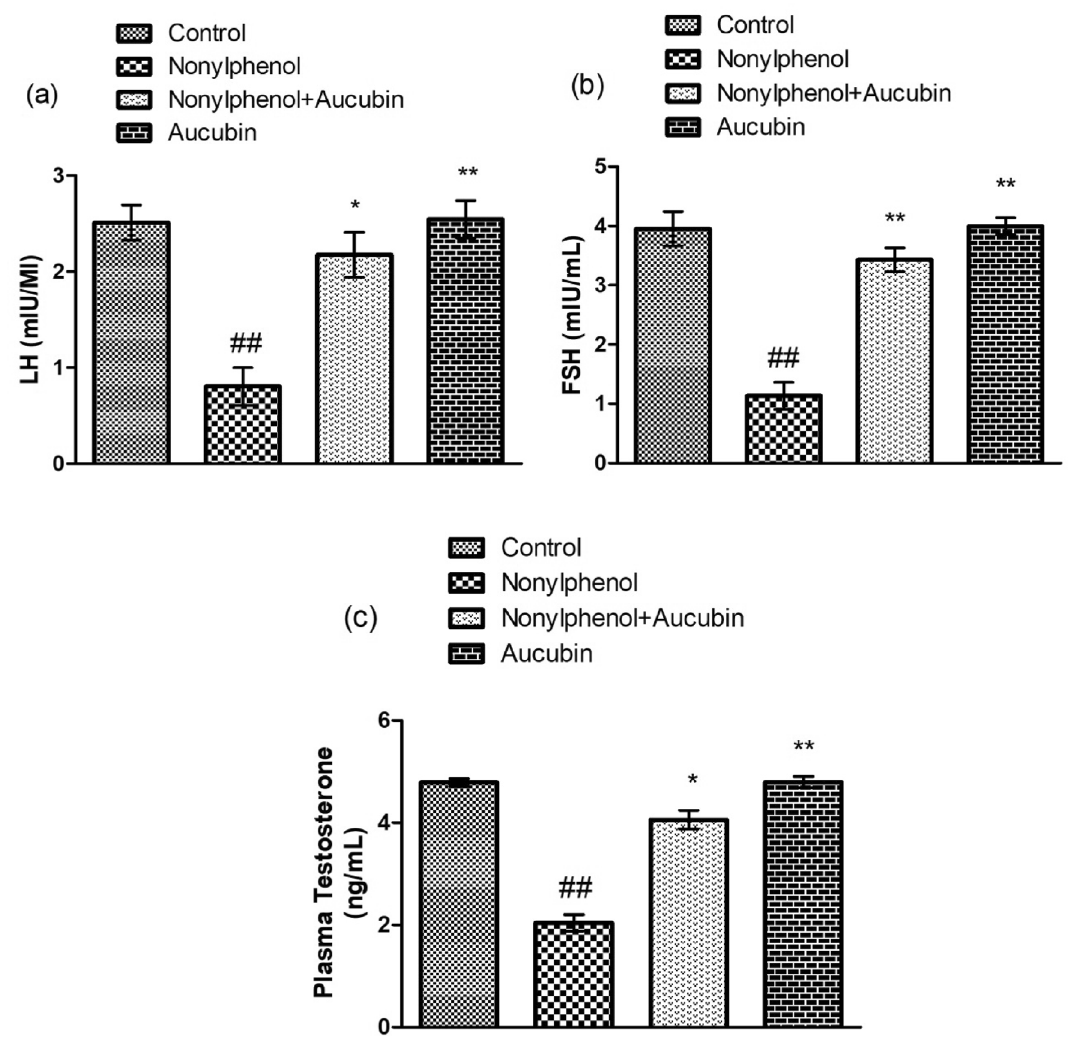
Figure 3. Effect of NP and AU on the levels of hormones: luteinizing hormone (LH) ( a ), follicle-stimulating hormone (FSH) ( b ), and plasma testosterone ( c ). Values are expressed as Mean ± SD (12 rats per group). Significant differences displayed as ## P < 0.01 compared to control; * P < 0.05, ** P < 0.05 compared to NP-treated